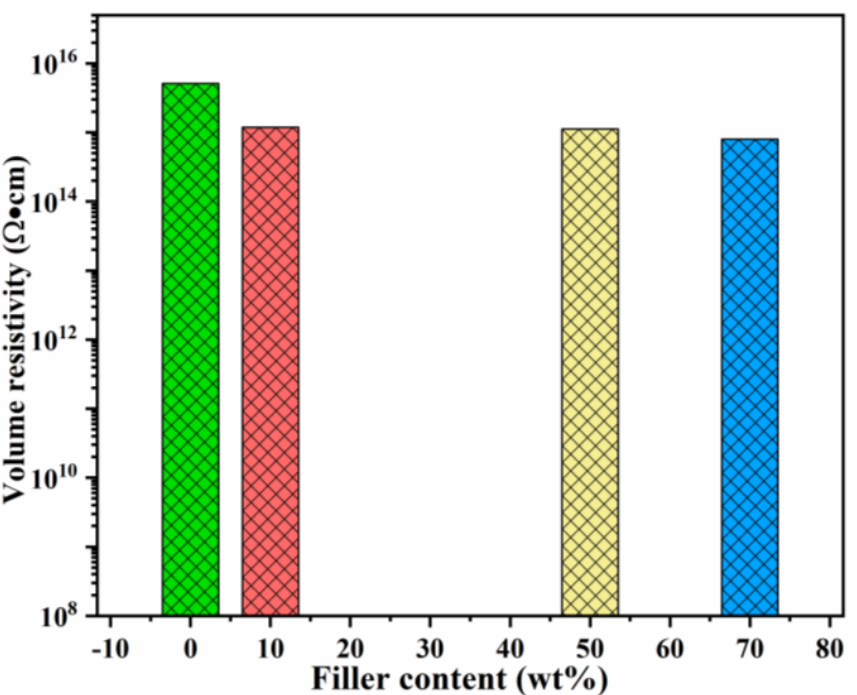
Figure 6. Volume resistivity of the B-Al 2 O 3 /SR composites. A dielectric constant characterizes the polarization degree of materials under the action of an electric field. Different application fields require various dielectric constants. When used as a capacitor, the dielectric constant of the material needs to be larger, while a smaller dielectric constant is needed in an insulating medium. The value of a dielectric constant of composite is determined by three aspects: the polymer matrix, particles and the interface region formed by them. The change of a dielectric constant of SR and its composites with frequency is shown in Figure 7a. In the whole test frequency range, the dielectric constant of pure SR is basically unchanged with the change in frequency (about 2.51), which is due to the siloxane used as a non-polar polymer and the fact that there are only electron and ion polarizations caused by impurity ions in the high frequency region [47]. With the decrease in frequency, no new polarization appears, and the dielectric constant remains unchanged. With the increase in B-Al 2 O 3 content, the dielectric constant of the composite increases gradually, but it remains stable in the whole tested frequency range. For example, for the composites with the addition of 50 wt% and 70 wt%, the dielectric constants are basically stable at about 3.53 and 4.61, respectively. The increasing dielectric constant of the composites is attributed to the fact that the inherent dielectric constant of Al 2 O 3 (9.8 at 1 MHz) is larger than the SR [48]. However, the dielectric constant of the composites does not notably increase, which can be attributed to the strong interface between the particle surface and the matrix hindering the dipole polarization [49]. Figure 7b shows the change in the dielectric loss of SR and its composites with frequency. Electric conductive loss caused by electrical conduction and polarization loss caused by relaxation polarization will be produced in dielectric materials under the action of an external electric field. SR material has poor conductivity and is a non-polar molecule; thus, its electric conductive loss and polarization loss are low, and the dielectric loss of pure SR is very low in the whole frequency range. With the addition of B-Al 2 O 3 , the dielectric loss of the composite barely increases, which also shows that the added B-Al 2 O 3 has high purity and almost no impurity molecules or water that increase the dielectric